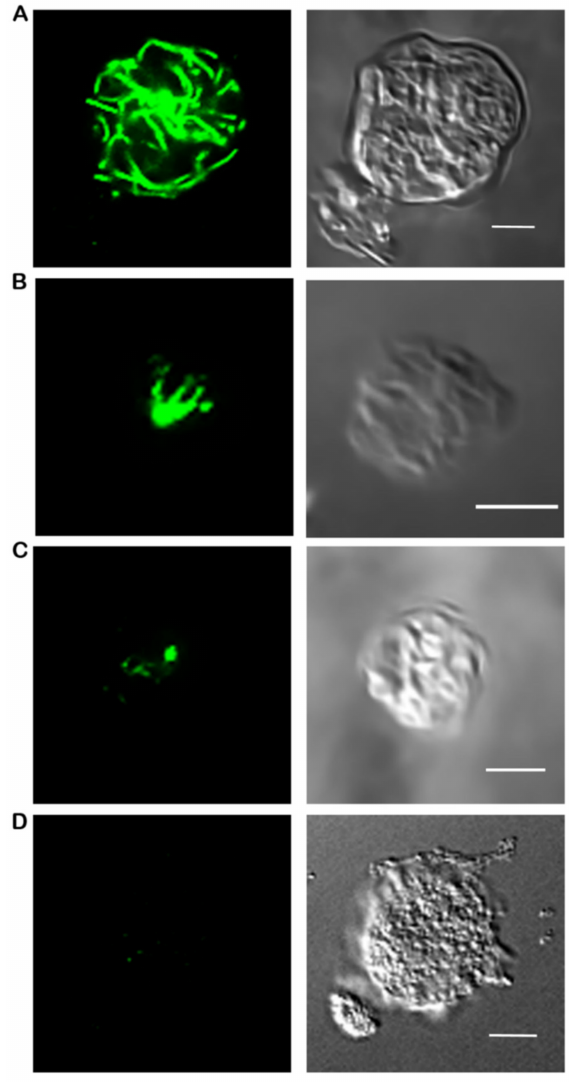
Figure 1. Microtubule Morphologies. ( A ) Fully intact microtubule structures with numerous tubules reaching toward the plasma membrane are characterized as intact. ( B ) A cytoskeleton that demon- strates an astral shape but does not extend to the plasma membrane is designated as partial. ( C ) Spot morphologies are where only the microtubule organizing center is present and ( D ) dead cells are when there is no detectable fluorescence (as shown here) or the plasma membrane is obviously no longer intact (data not shown). Scale bar is 5 µ